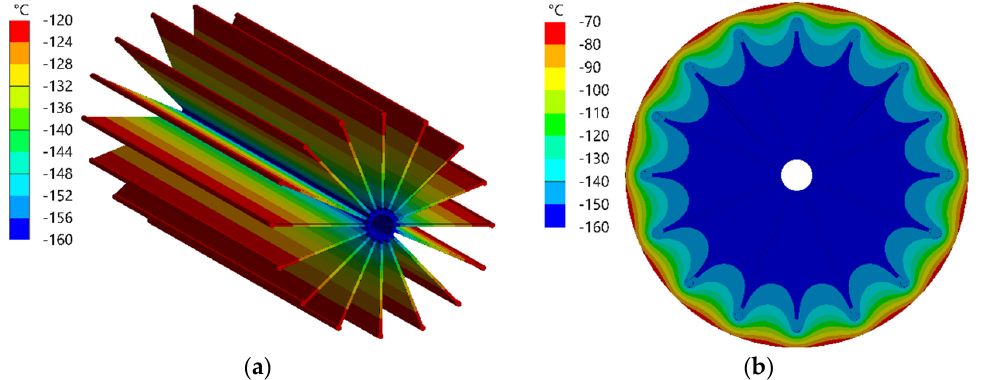
Figure 12. Temperature distribution: ( a ) 16 fins—no frost, ( b ) 16 fins with frost.